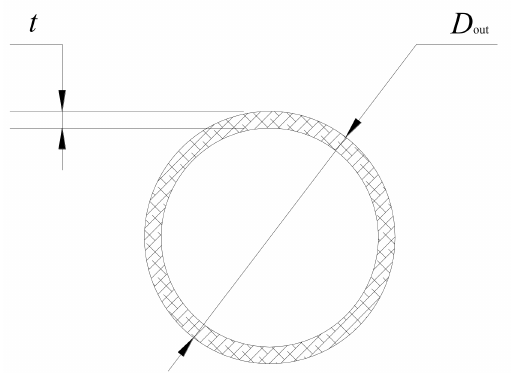
Figure 2. Section of the PLA micro tube.